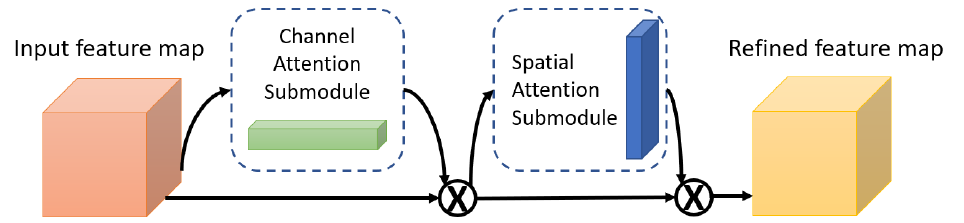
Figure 2. The Convolutional Block Attention Module (CBAM).